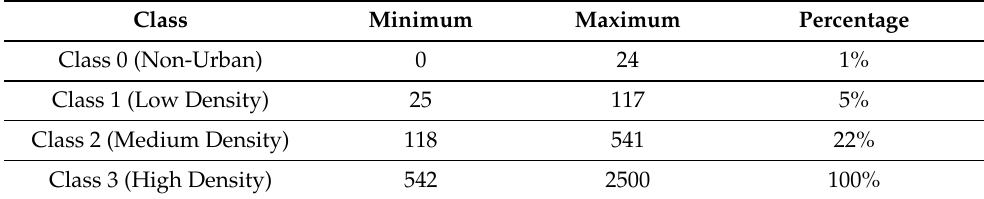
Table 1. Number of 2 ∗ 2 m cells in 100 m 2 image (represented in